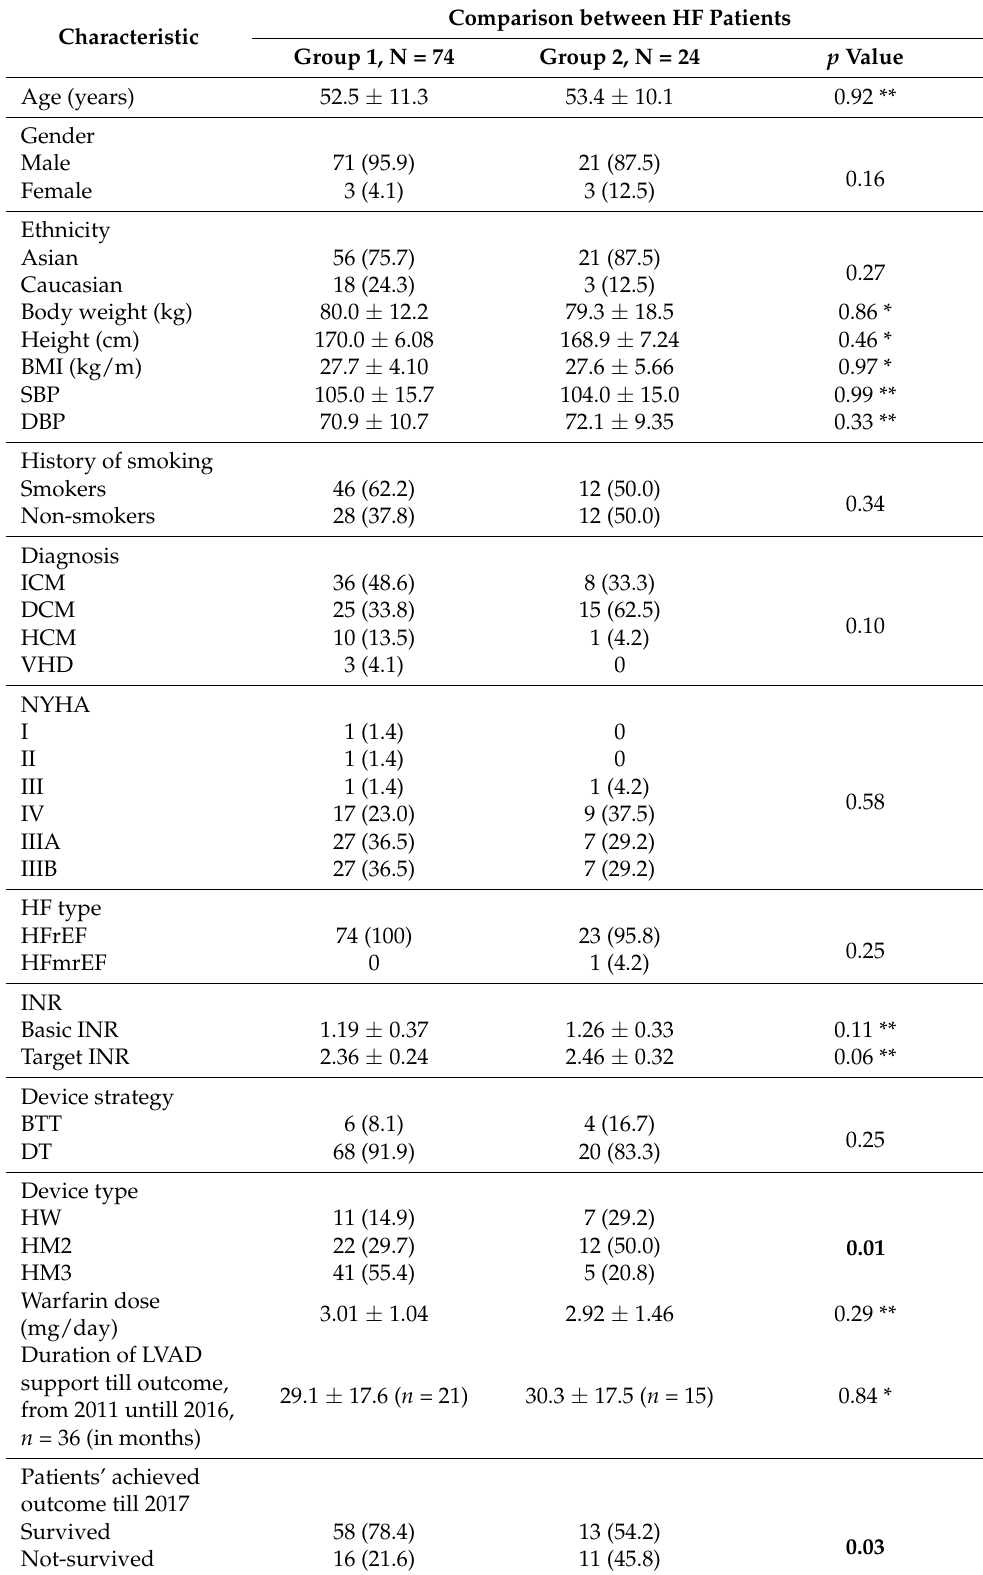
Table 2. Comparison of baseline demographic characteristics of patients with/without